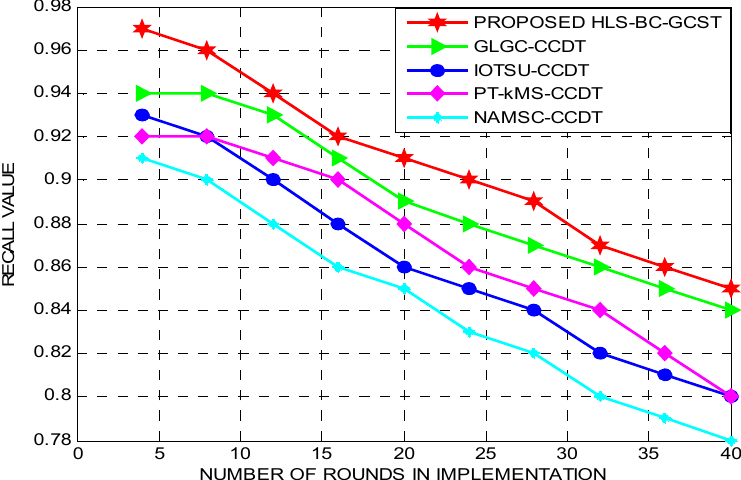
Figure 9. Proposed HLC-BC-GCST scheme evaluated using recall value. Tables 1–3 highlight the performance of the proposed HLC-BC-GCST scheme, where different metrics are used to compare and evaluate the existing systems’ performance over the proposed system. The results obtained by the proposed system show an increase in the overall performance accuracy of the detection of cervical cancer. Table 1. Comparative Performance: Accuracy and